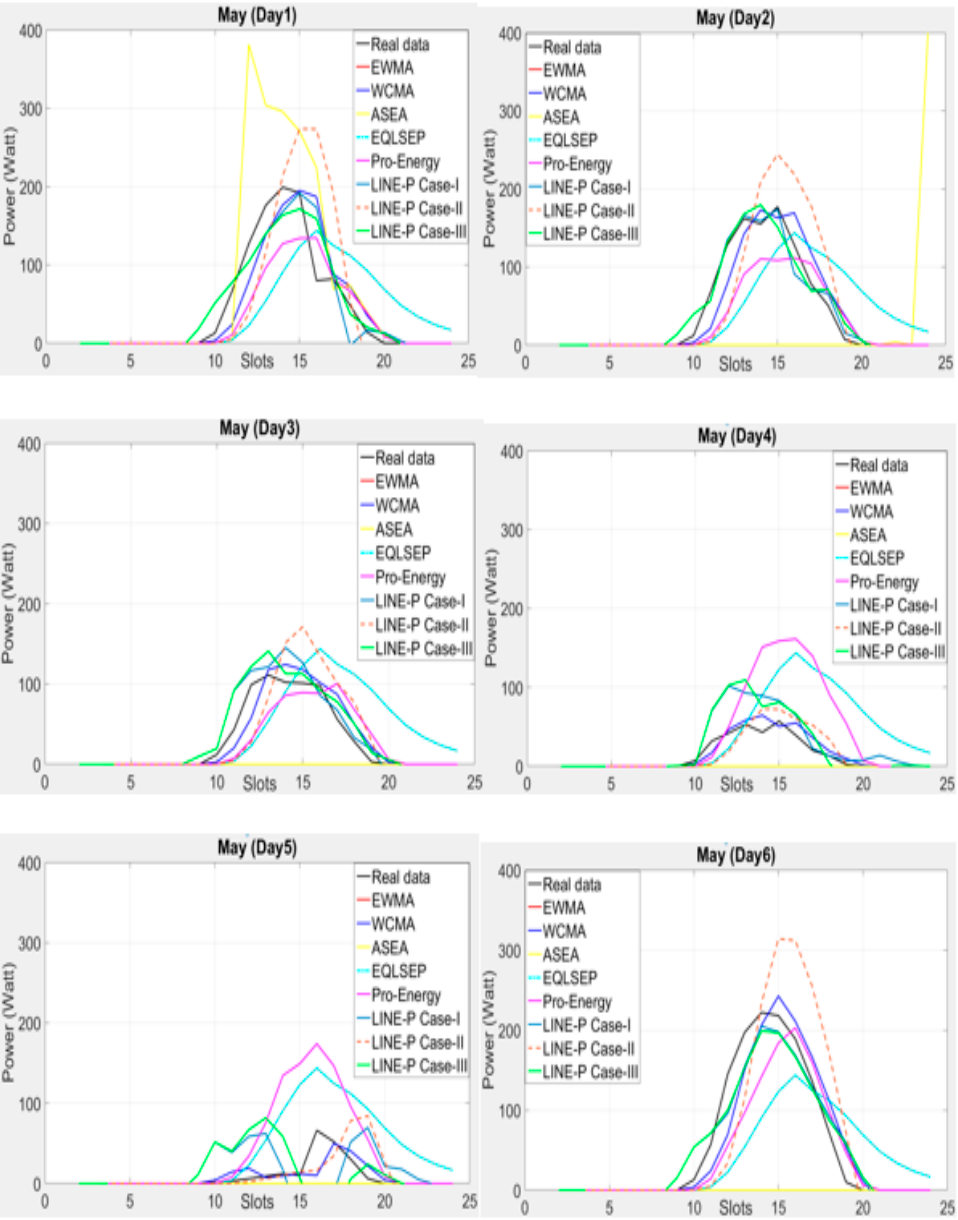
Figure 3. Graphical comparison of the obtained predictions for all models (including the proposed LINE-P cases) for longer interval-based (24 slots) solar energy in May. Here, even ASEA is not always able to deal with energy variations; in contrast, LINE-P Case-I and Case-III provide more realistic and accurate values.